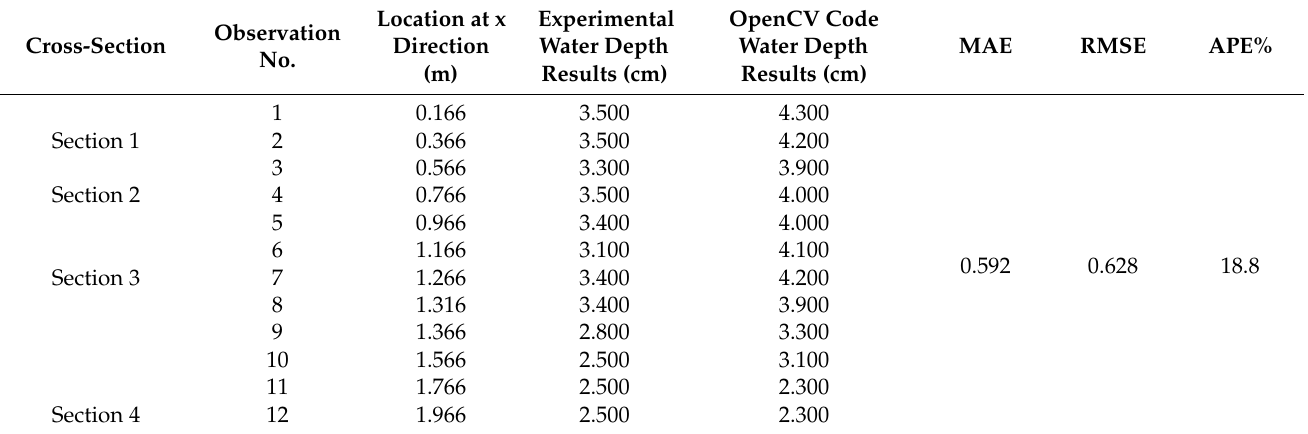
Table 8. Comparison of experiment and CFD water depth